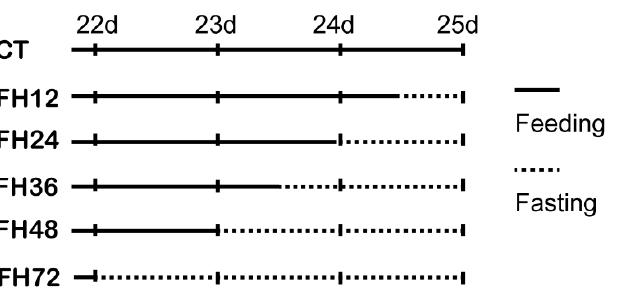
Figure 1. Fasting procedure. CT—birds fed ad libitum; FH12—birds fasted for 12 h; FH24—birds fasted for 24 h; FH36—birds fasted for 36 h; FH48—birds fasted for 48 h.